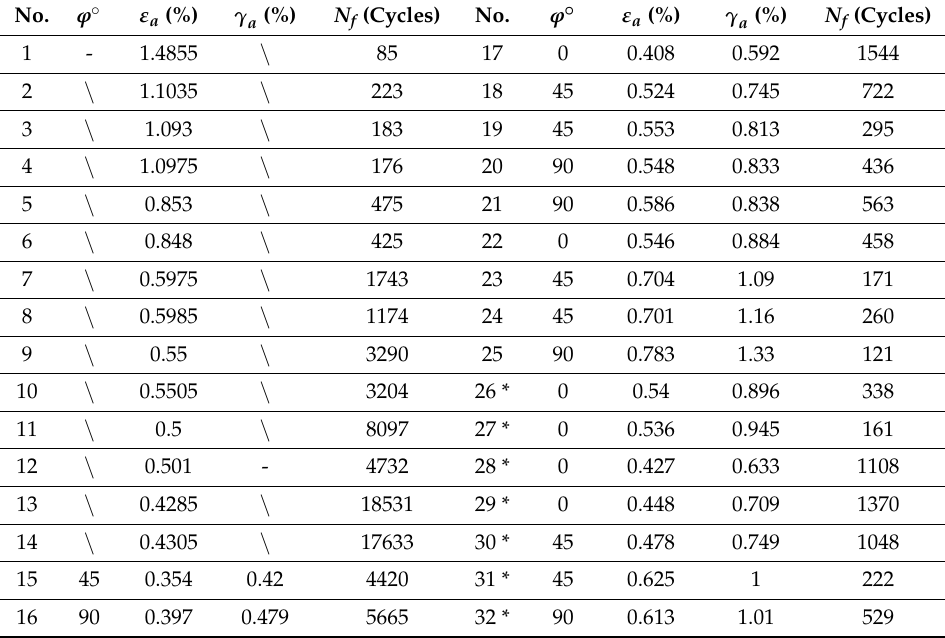
Table 5. Fatigue test data of GH4169 at 650 ◦